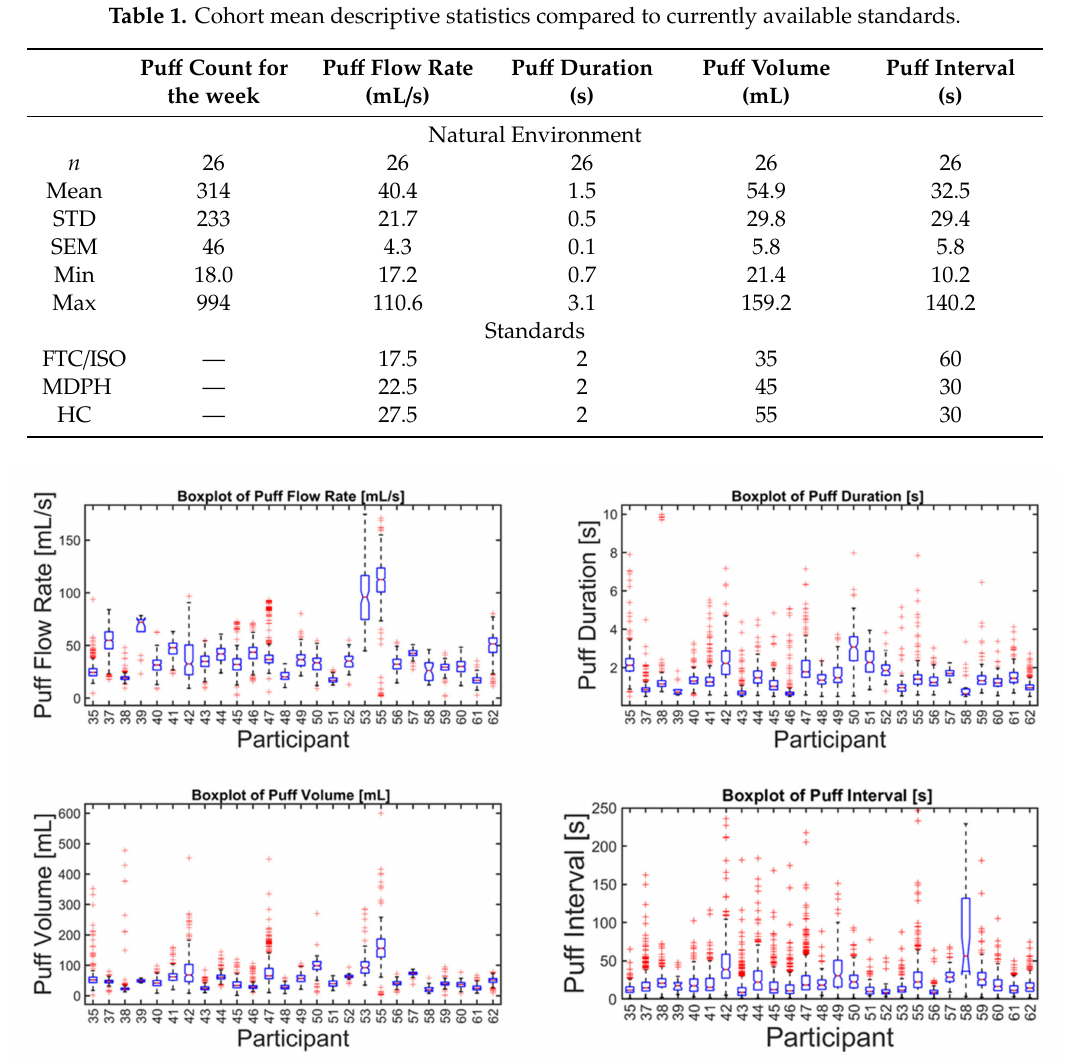
Figure 3. Descriptive statistics of pu ff flow rate, duration, volume, and interval of ( n = 26 smokers) cigarette smokers in their natural environment during a week-long observation period ( n = 8250 pu ff s). The box plot for each parameter and participant indicates the median (50th percentile, red horizontal line), 95% confidence interval on the median (box notches), 25th and 75th percentiles (lower and upper edge of boxes, respectively), lower and upper fences or whiskers (vertical lines representing 1.5 times the interquartile range), and data outliers (red